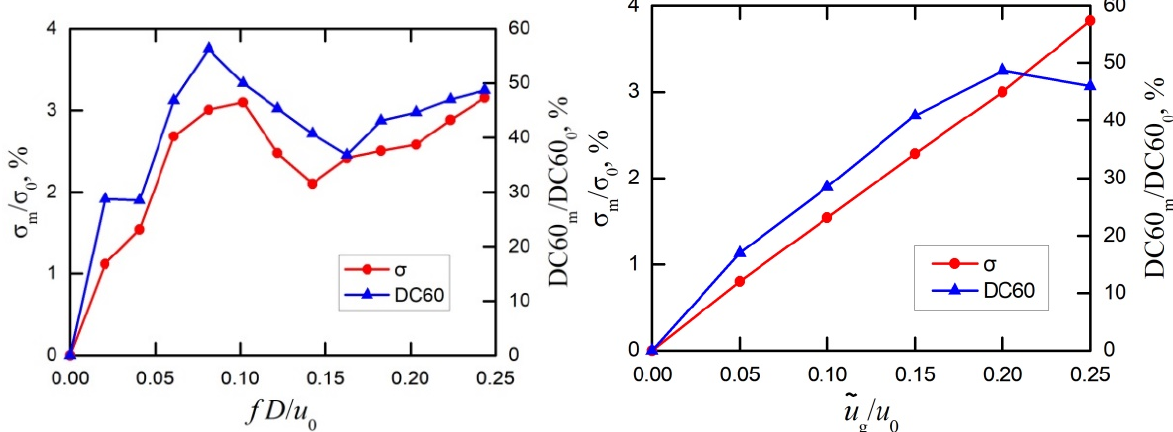
Figure 28. Non-dimensional amplitudes of the total pressure recovery and distortion responses for the non-dimensional gust frequency f D/ u 0 and non-dimensional gust amplitude (cid:101) u g / u 0 , respectively. To compare the effect of gusts on increasing the fluctuations of the inlet performance with the intrinsic unsteadiness of the flow field in the absence of gusts, Table 5 lists the maximum amplitudes of total pressure recovery and distortion fluctuations for the gust cases investigated in this study as well as for the no-gust case. This demonstrates that the gusts have amplified the total pressure recovery and distortion fluctuations by several times the fluctuations caused by the intrinsic unsteadiness of the flow field. This may validate the above hypothesis of the production of resonance in the flow field by the interaction between the gusts and the